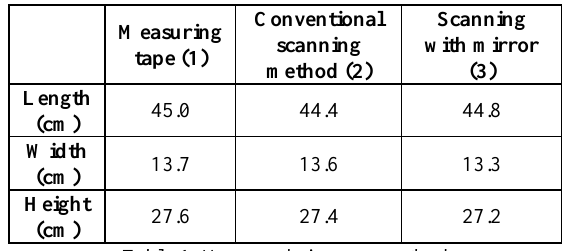
Figure 16: Point cloud comparison (front part of the